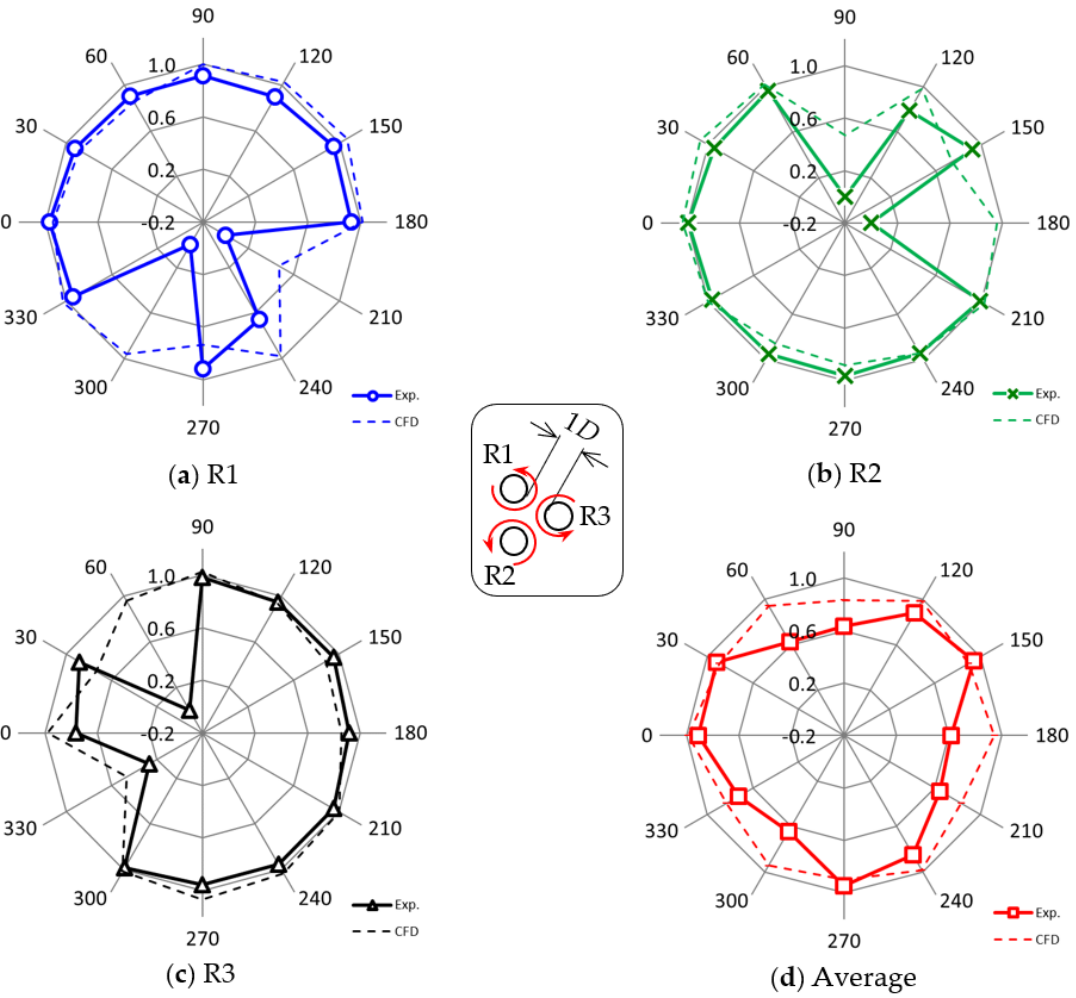
Figure 19. Comparison between the experimental and CFD results on 12-wind-direction dependence of normalized rotational speed in a trio of VAWT models at g / D = 1 in the 3CO configuration: ( a ) Rotor 1; ( b ) Rotor 2; ( c ) Rotor 3; ( d )